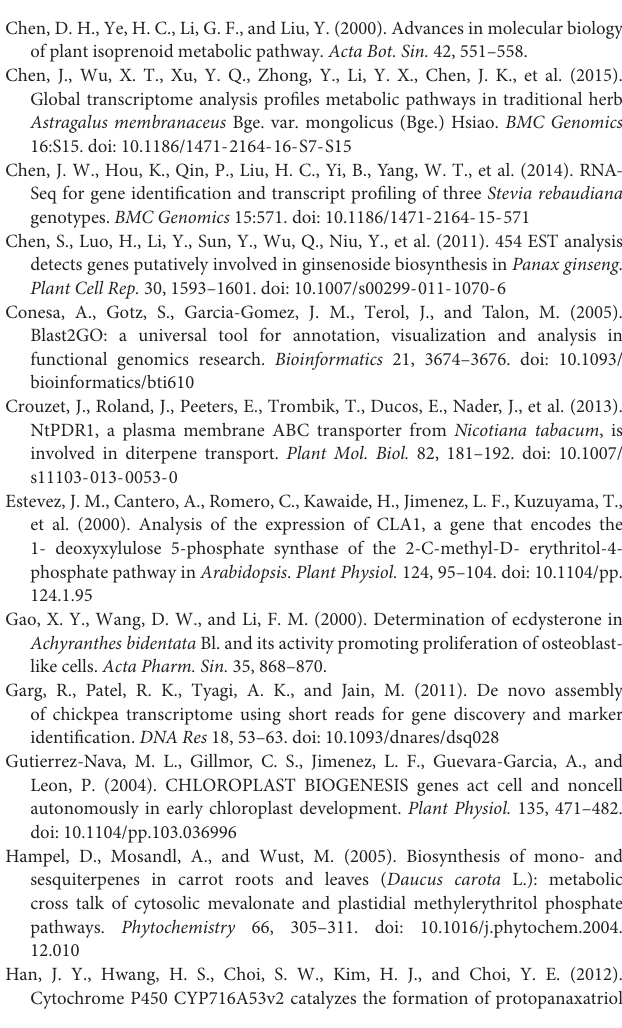
FIGURE S1 | Phylogenetic analysis of five identified HMGR from our dataset and other plant HMGRs. Phylogenetic tree was generated using the neighbor-joining (NJ) method in MEGA6. HMGR of this study is shown in red